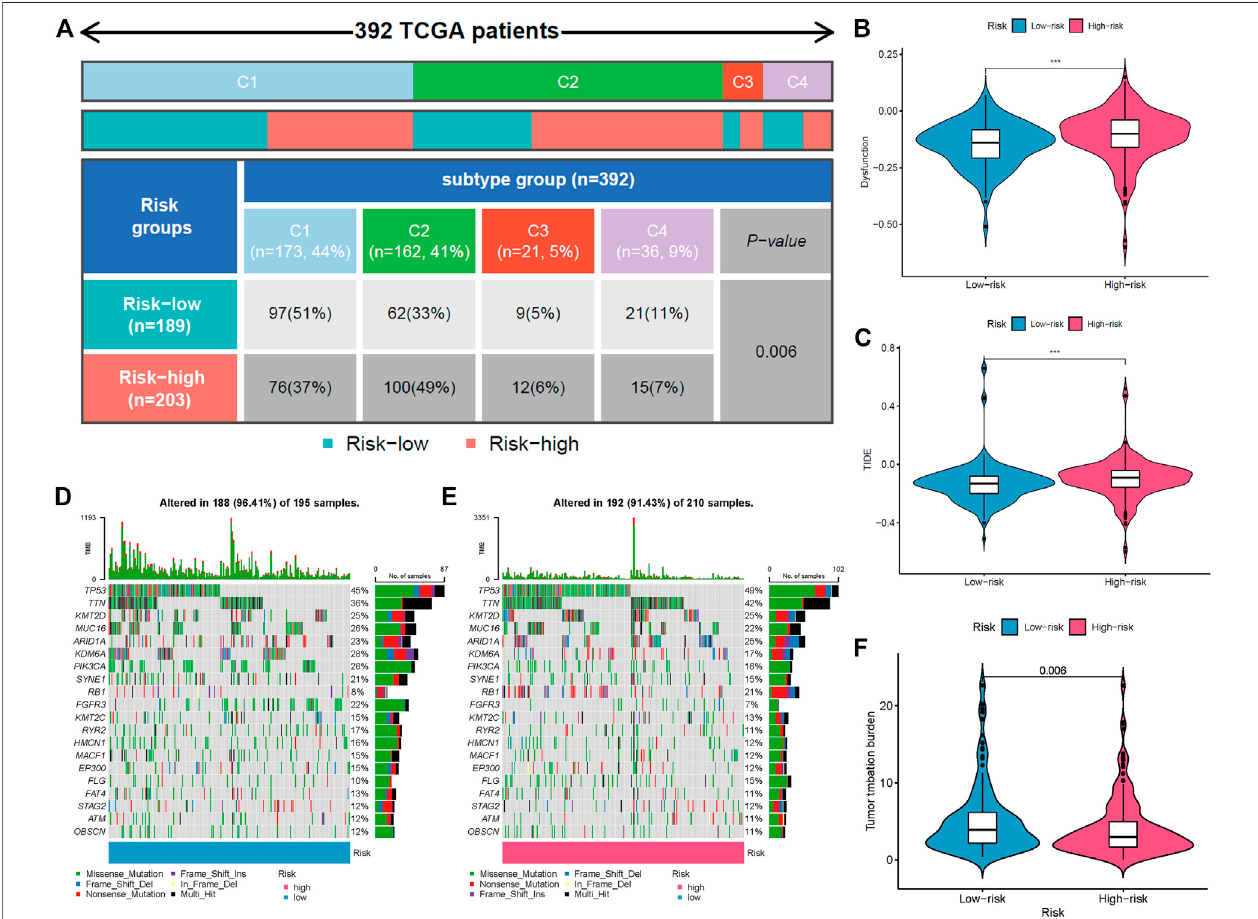
FIGURE 8 | Comparison of two risk groups in molecular typing of immune subtypes, tumor mutation burden (TMB), and immune escape. (A) Proportion of molecular typing of immune subtypes. (B) The high-risk group had more immune dysfunction. (C) Compared with the low-risk group, the high-risk group had higher Tumor Immune Dysfunction and Exclusion (TIDE) score and greater potential of immune escape. (D) TMB of the low-risk group. (E) TMB of the high-risk group. (F) Statistical analysis of TMB in two risk groups.